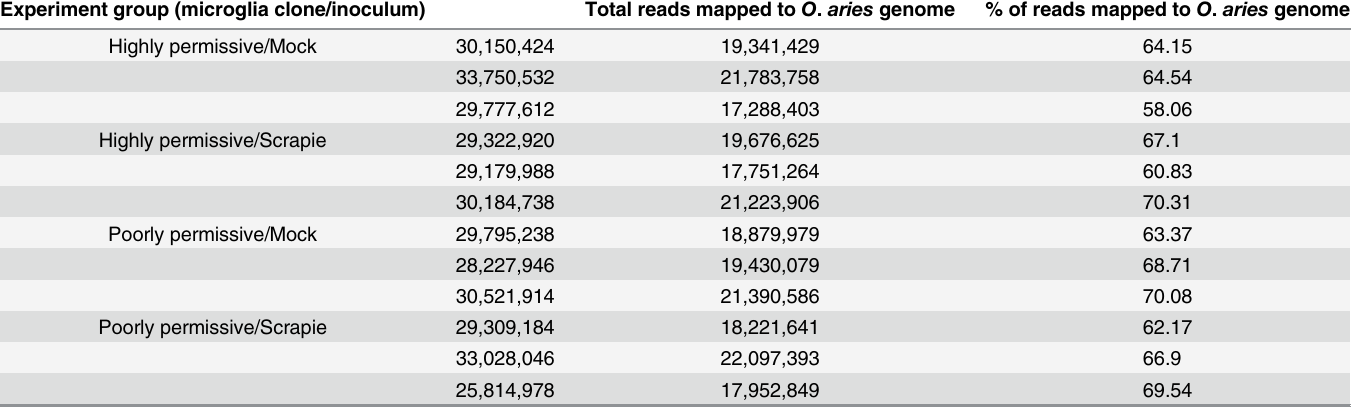
Table 2. Reads mapped to O . aries genome.